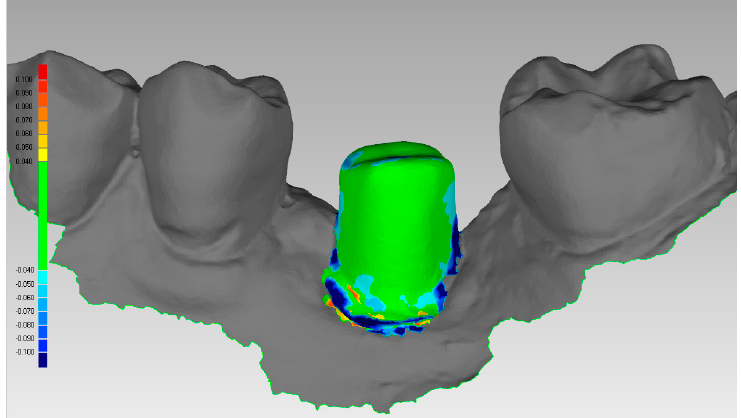
Figure 11. Mathematical control of the quality of the superimposition obtained with Exocad ® . The files of the drawing of the individual hybrid abutment, from PLAN1, and the second scan (SCAN2), superimposed with the powerful algorithms of Exocad, are saved in that position and imported in a powerful reverse ‐ engineering (Studio2012 ® , Geomagics, Morrisville, NC, USA). This software is used to calculate the distance/difference between the two files. A color ‐ coded scale is generated, that revels little distances/deviations between the two surfaces.